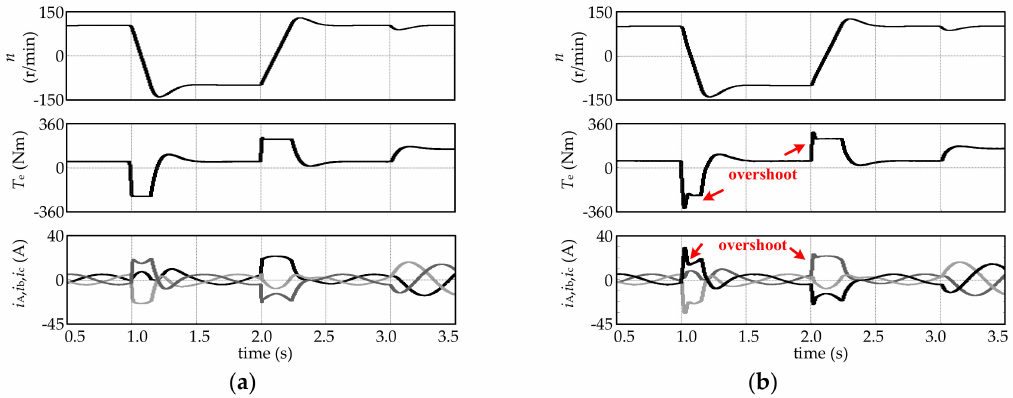
Figure 9. Speed dynamic simulation waveforms. ( a ) The improved DTC-SVM scheme; ( b ) the conventional DTC-SVM